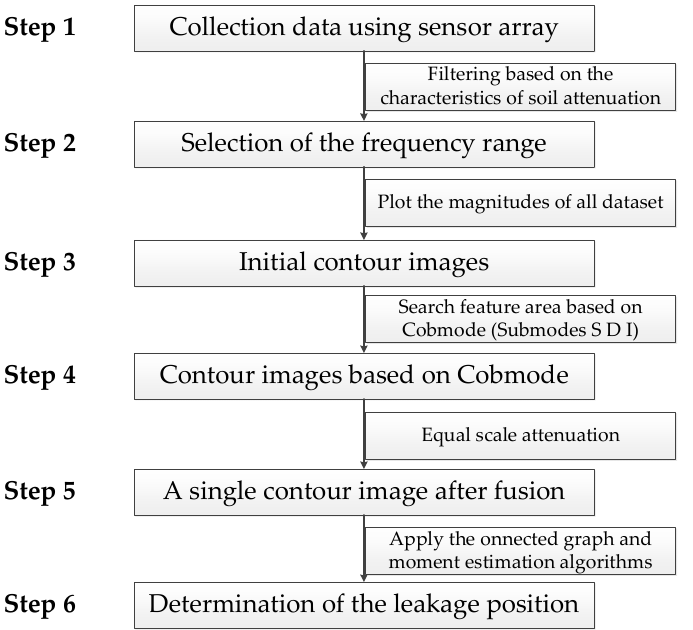
Figure 11 . Steps for the mapping and locating the pipe leakage based on ground surface vibration